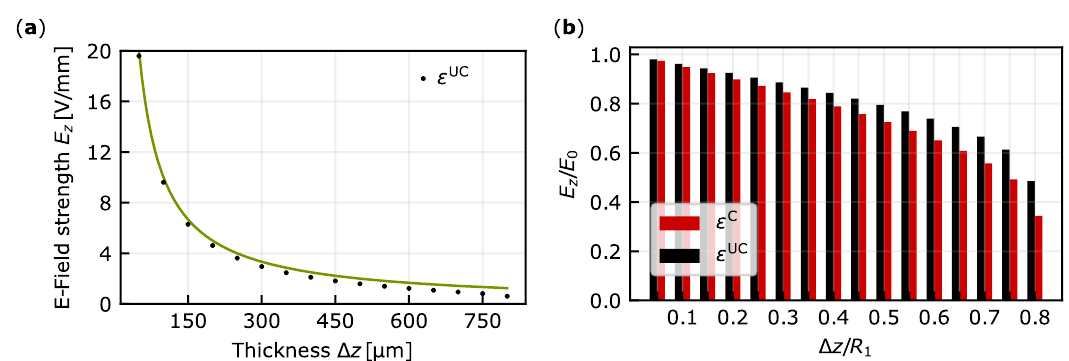
Figure 4. ( a ) The average electric field strength in the area where the intensity is larger than 10% of its maximal intensity of the fundamental optical mode for R 1 = 1000µm and different thicknesses ∆ z . The green line indicates the field strength E z according to E z = E 0 = U / ∆ z . ( b ) Comparison between the electric field E z and the respective field in a plate capacitor E 0 for different ∆ z / R 1 . The error bars have point size.